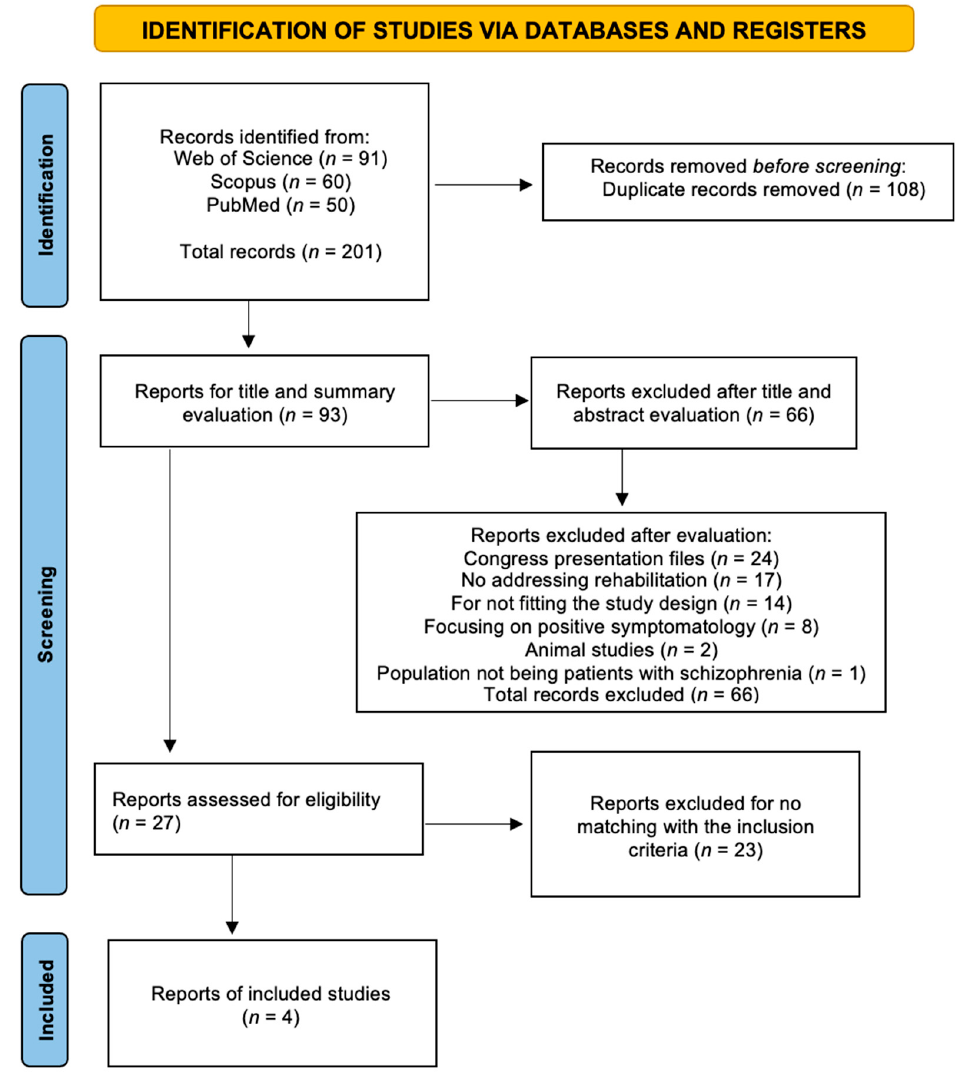
Figure 1. PRISMA flow diagram highlighting the selection process for the studies included in this systematic review [17].